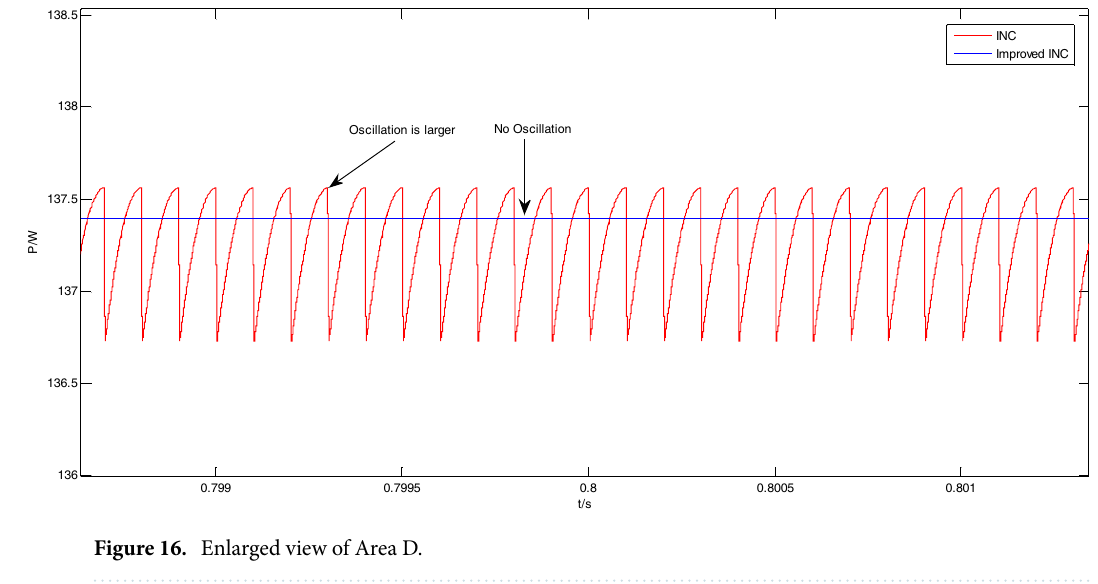
Figure 16. Enlarged view of Area